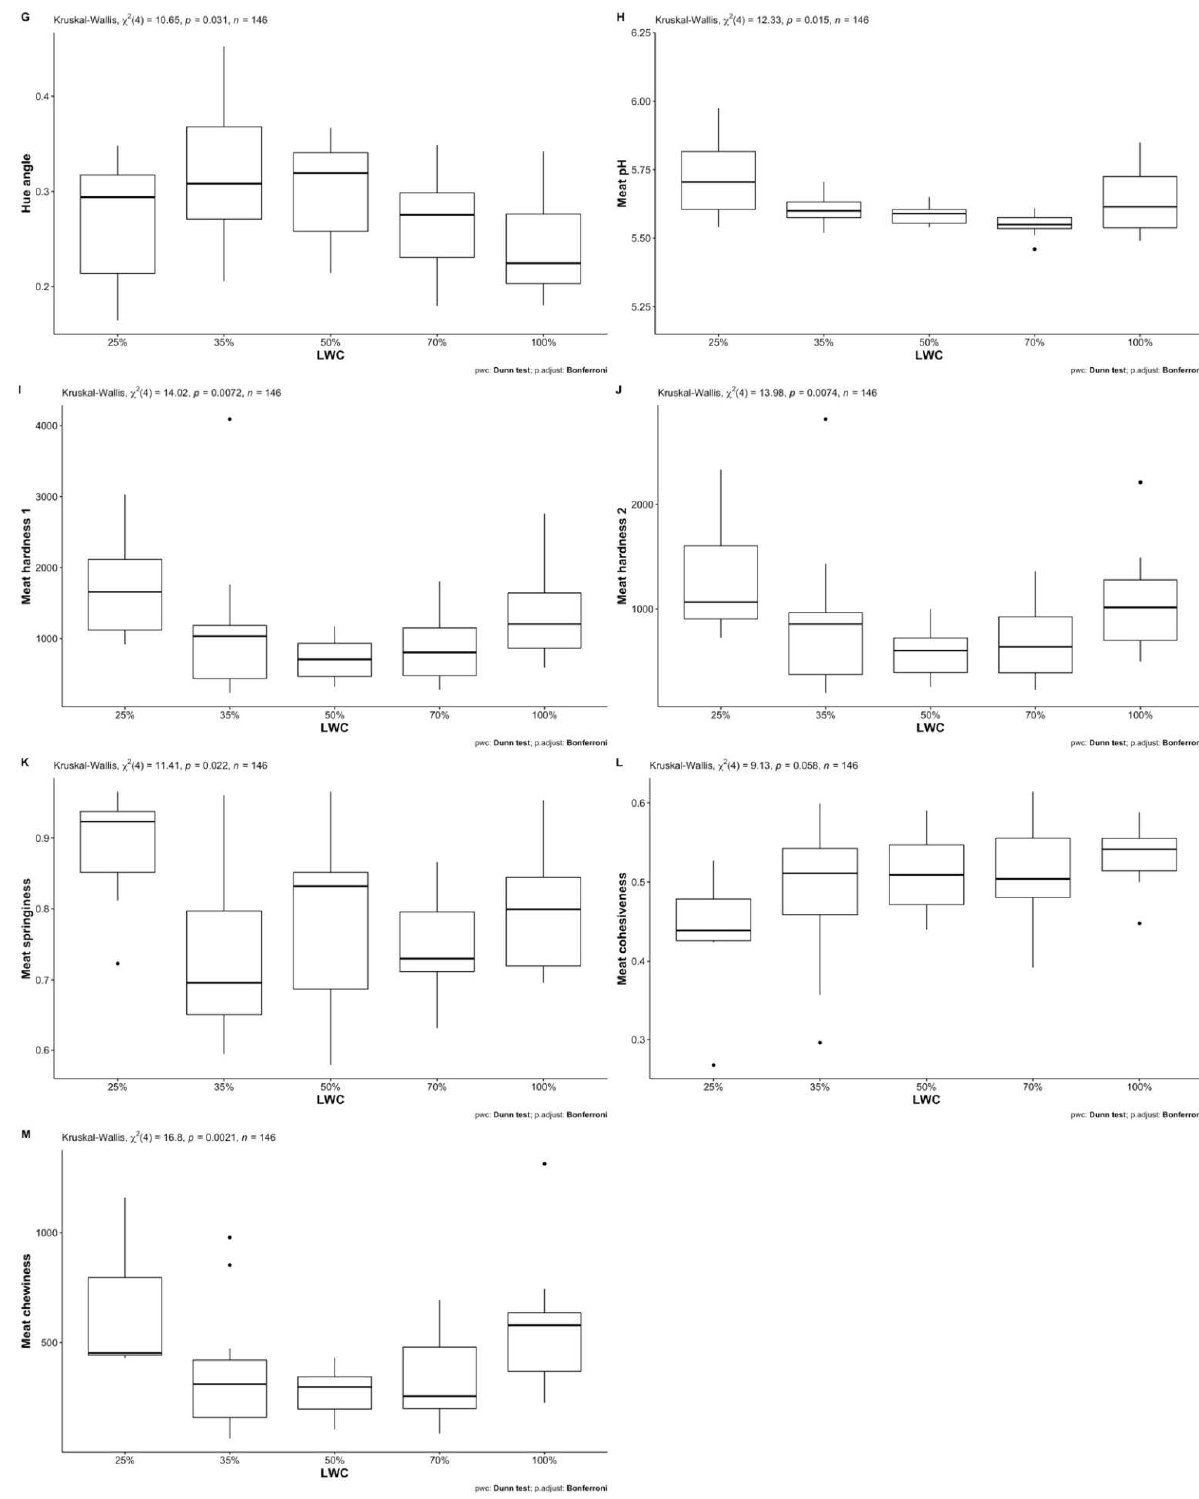
Figure 1. Dunn’s post hoc analysis for pairwise comparisons between live-weight categories (LWC) of fat-tailed sheep regarding the tested traits: ( A ) Live weight—in kg; ( B ) Wither height—in m; ( C ) Carcass length—in m; ( D ) Carcass weight—in kg; ( E ) Carcass yield—as %; ( F ) Lightness—L*; ( G ) Hue angle; ( H ) Meat pH; ( I ) Meat hardness 1; ( J ) Meat hardness 2; ( K ) Meat springiness; ( L ) Meat cohesiveness; ( M ) Meat chewiness.